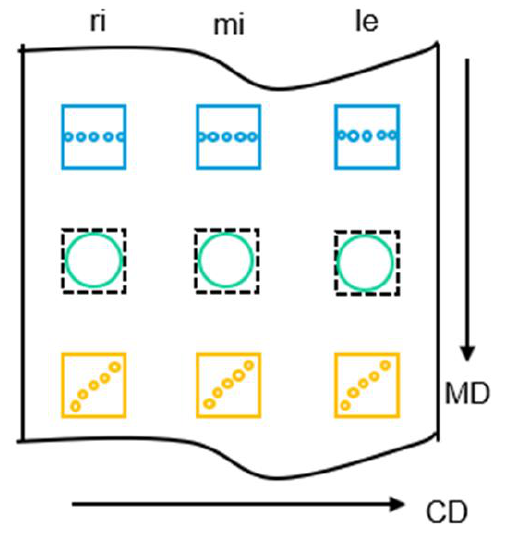
Figure 2. Scheme of the sampling on the produced nonwovens for analysis of nonwoven properties and homogeneity (distribution); squares: 10 × 10 cm for area base weight measurements; blue dots: sampling of area base weight in finer resolution (0.782 cm 2 ); green circles: air permeability (20 cm 2 ); yellow dots: thickness measurements (1 cm 2 ); abbreviations: machine direction (MD), cross direction (CD), left (le), middle (mi), and right (re).